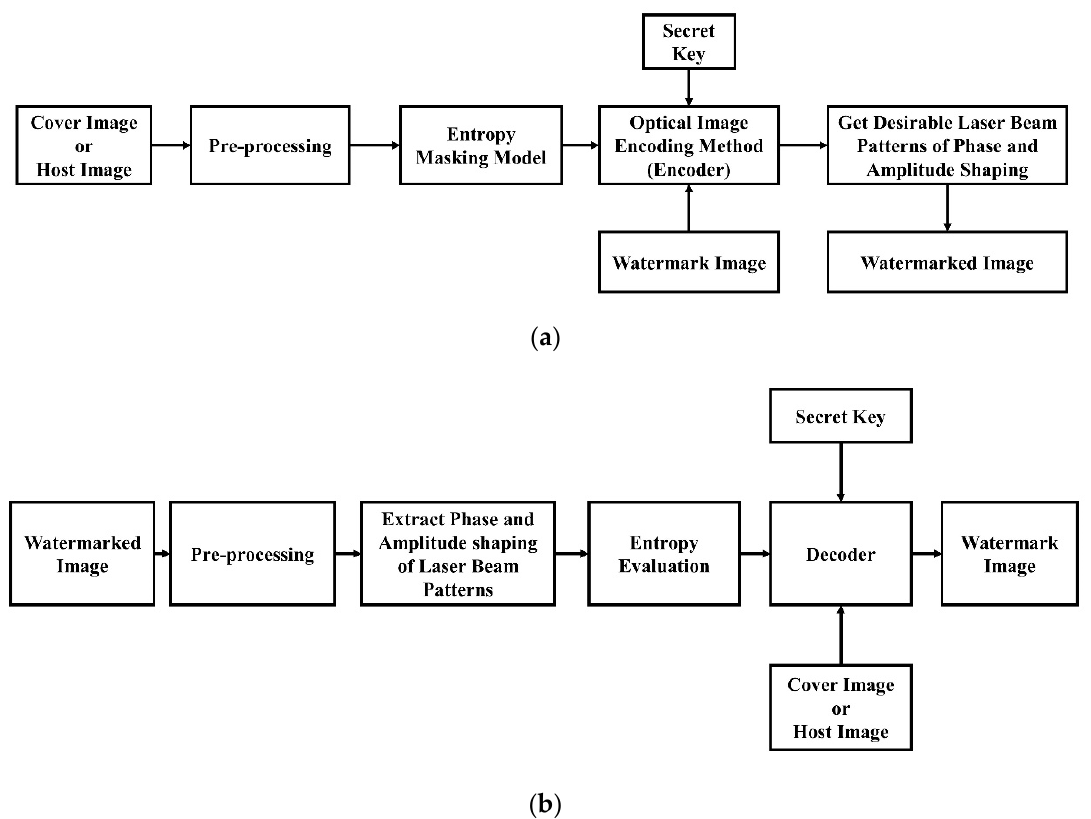
Figure 1. ( a ) Watermark embedding and ( b ) watermark extraction.